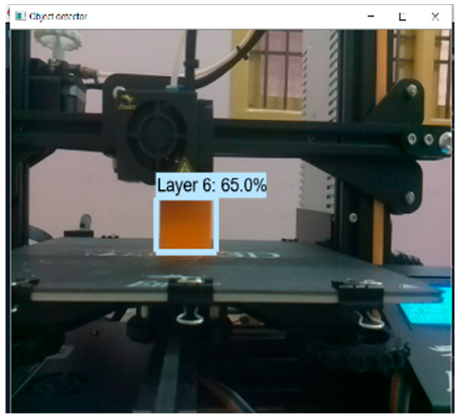
Figure 11. Live testing results .